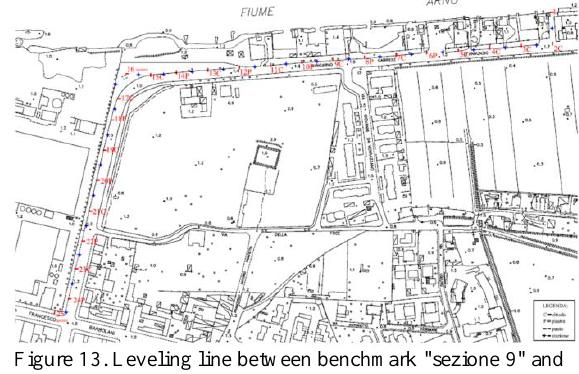
Figure 13. Leveling line between benchmark "sezione 9" and piezometric wells